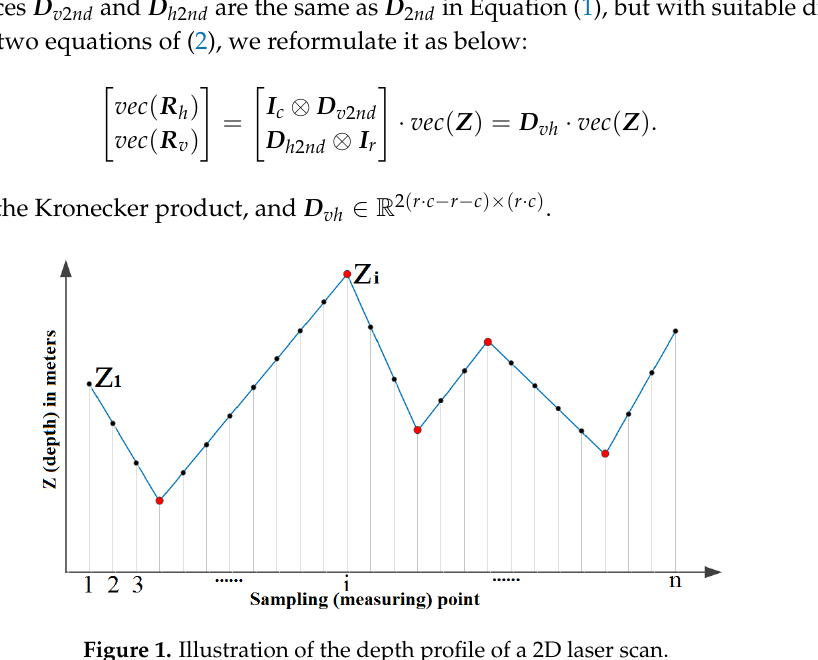
Figure 1. Illustration of the depth profile of a 2D laser